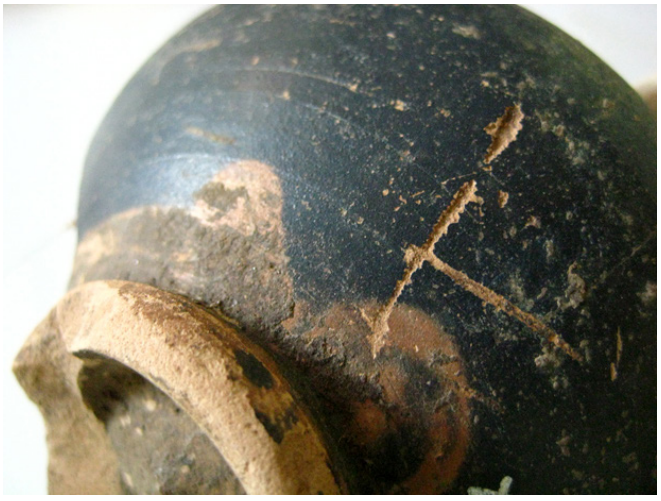
Figure 4. Black gloss bowl from Satricum showing the fingerprints left by the potter in the clay slip while dipping. Photo by A.E.M. Dekker (courtesy of Satricum Research